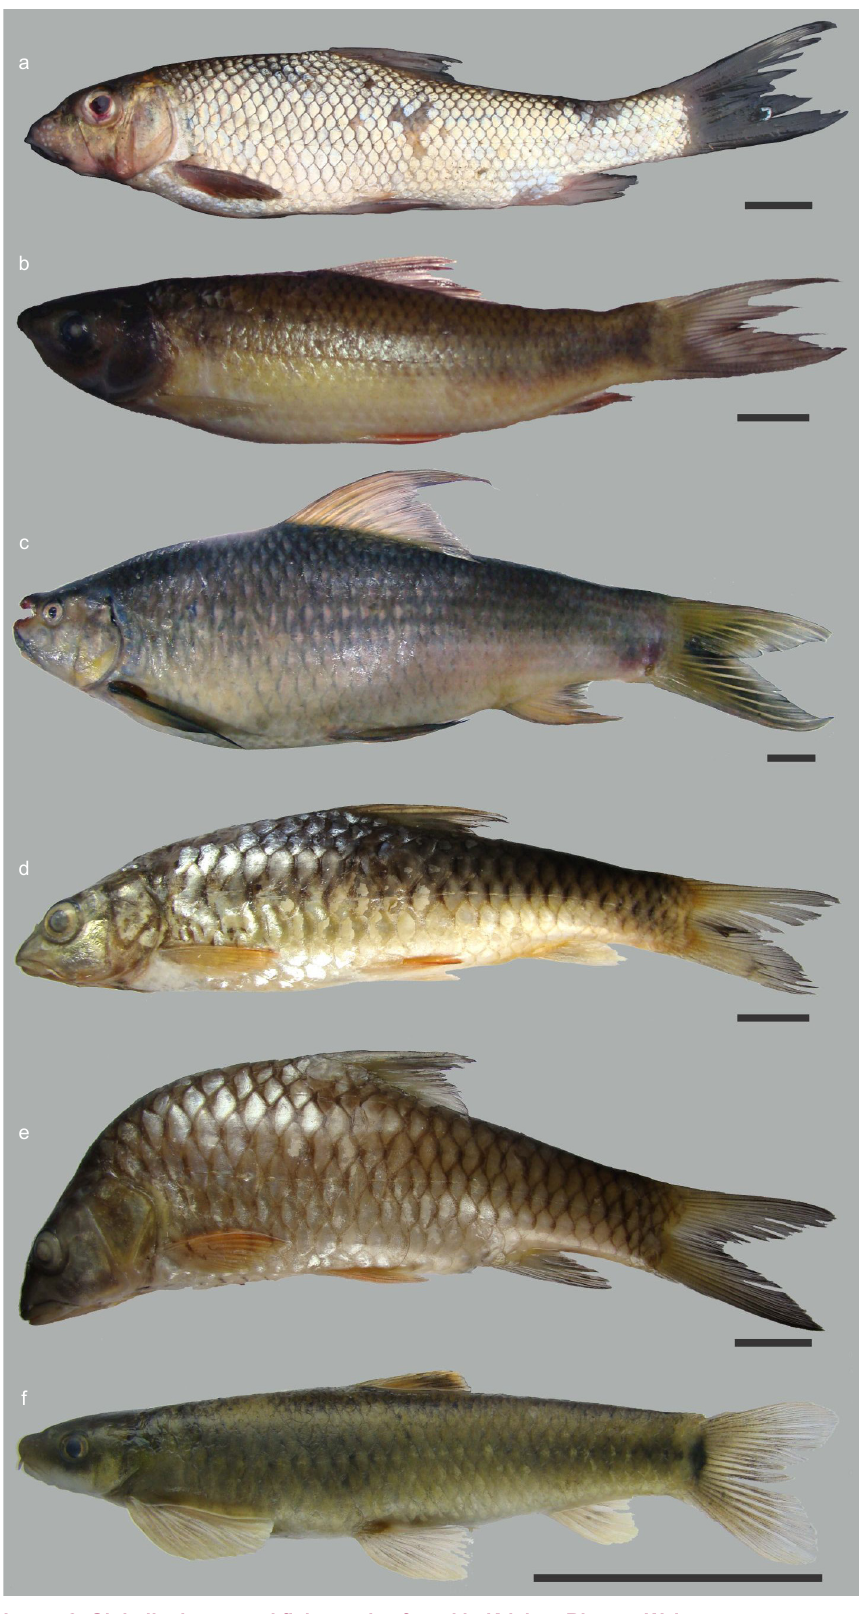
Image 2. Globally threatened fish species found in Krishna River at Wai. a - Gonoproktopterus curmuca ; b - Labeo potail ; c - Schismatorhynchos nukta ; d - Tor mussullah ; e - Tor khudree ; f - Parapsilorhynchus discophorus . Scale bar indicates